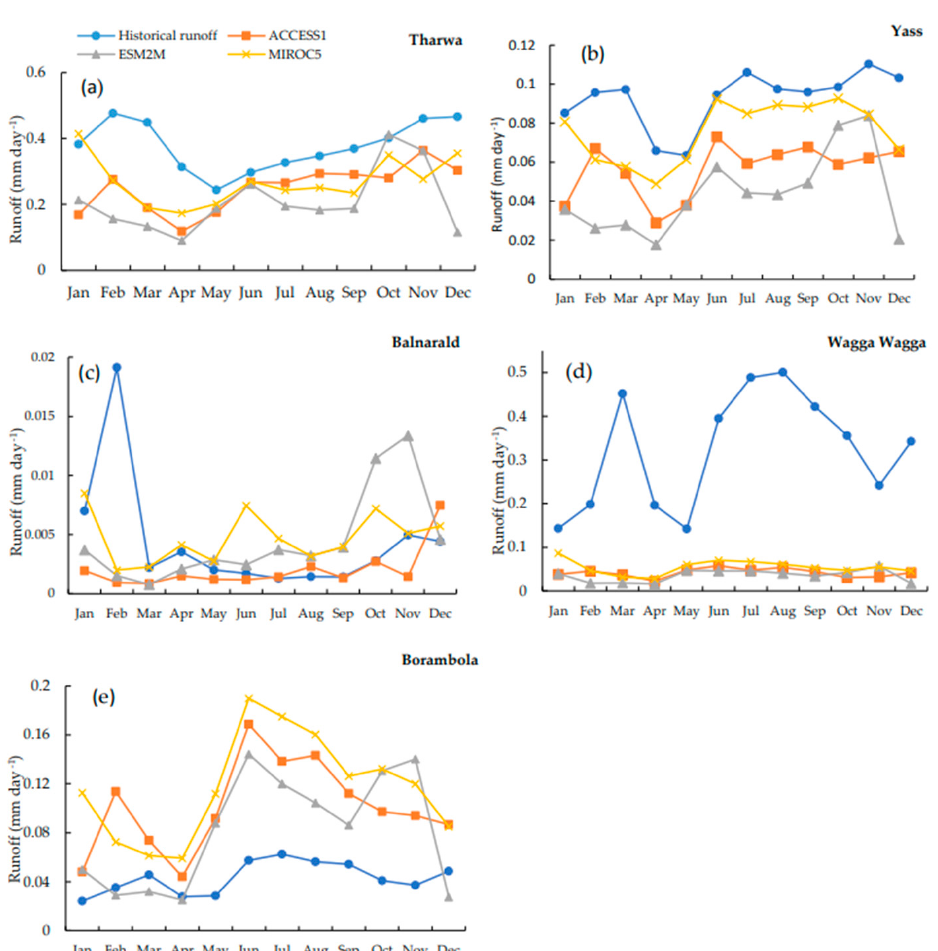
Figure 11. The average monthly projected and historical observed runoff trend under the RCP4.5 climate scenario at five different sub-catchments within the Murrumbidgee River catchment. Three GCMs projected future runoff trends under the RCP4.5 climate scenario for period of 2016–2035 plotted against observed historical runoff at five different sub-catchments; a) projected and historical runoff at Tharwa, b) projected and historical runoff at Yass, c) projected and historical runoff at Balranald, d) projected and historical runoff at Wagga Wagga, e) projected and historical runoff at Borambola.